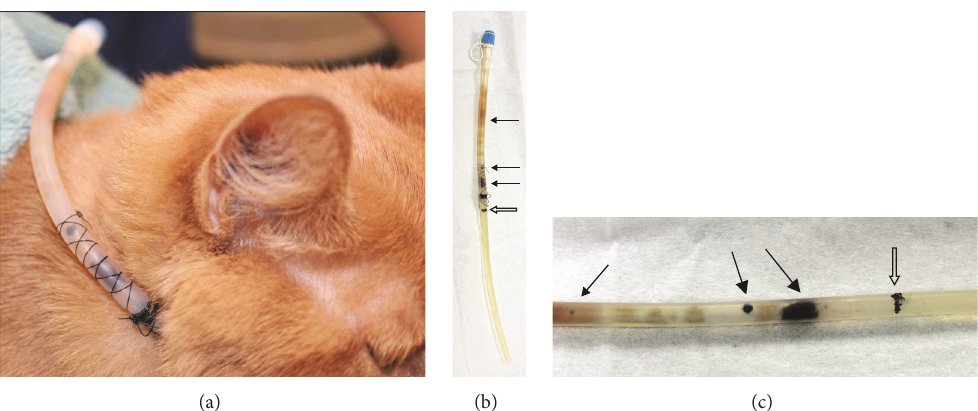
Figure 1: A silicon esophagostomy tube exposed for 77 days in a cat (case 1). (a) The esophagostomy tube prior to removal. Note the multifocal darkly pigmented plaques, primarily within the area of the suture finger trap at the site of tube insertion. (b) The esophagostomy tube after removal. Solid black arrows highlight darkly pigmented plaques, while thinner, lighter colored plaques extend up the insertion tube. The hollow arrow indicates a marker line at the site of interface of the tube and stoma. Note the lack of plaques below the interface line. (c) Close- up photo of the esophagostomy tube after removal of the suture finger trap. Solid black arrows highlight the most prominent plaques. The hollow arrow indicates a marker line at the site of insertion into the